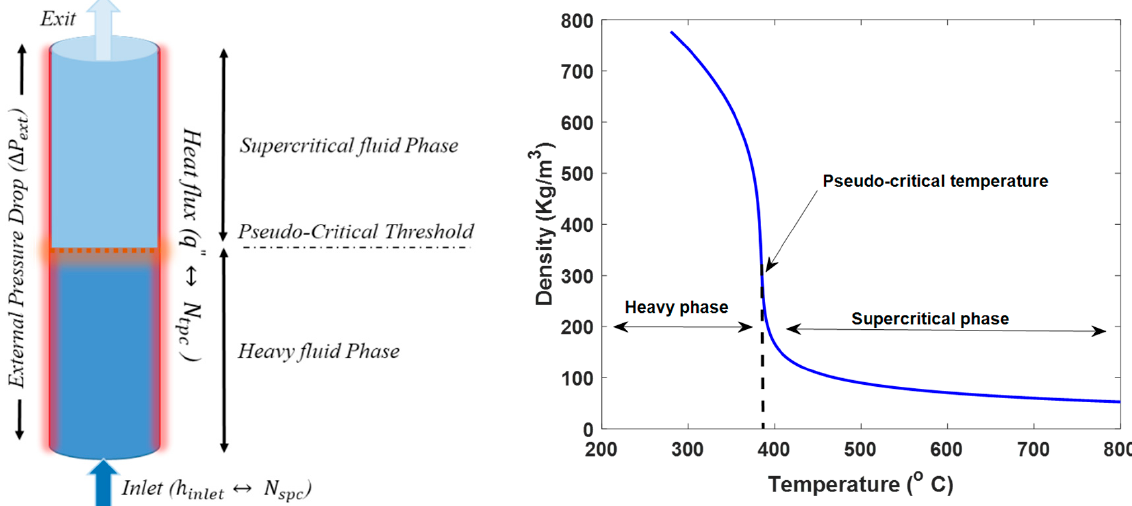
Figure 3. A systematic view of the two-node heated channel.